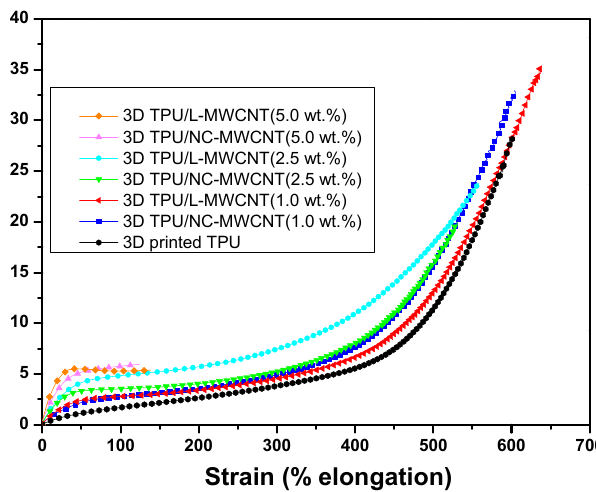
Figure 5. Stress–strain curves of all 3D printed samples, namely TPU, TPU / NC-MWCNT and TPU / L-MWCNT nanocomposites at 1.0, 2.5 and 5.0 wt.% MWCNT loadings.